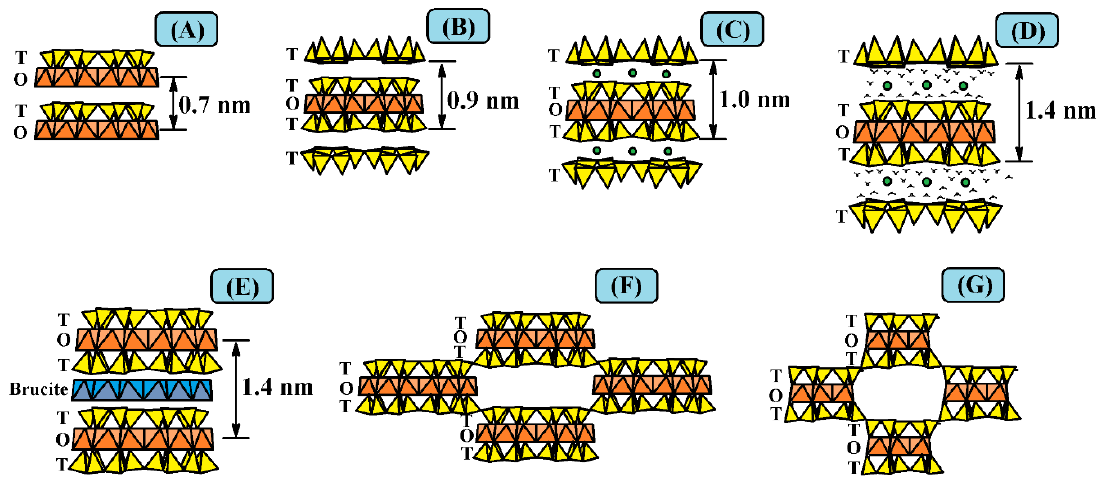
Figure 2. Chemical structure of the kaolinite and serpentine group ( A ); talc and pyrophyllite group ( B ); mica groups ( C ); smectite and vermiculite group ( D ); chlorite group ( E ); sepiolite ( F ) and palygorskite ( G ).